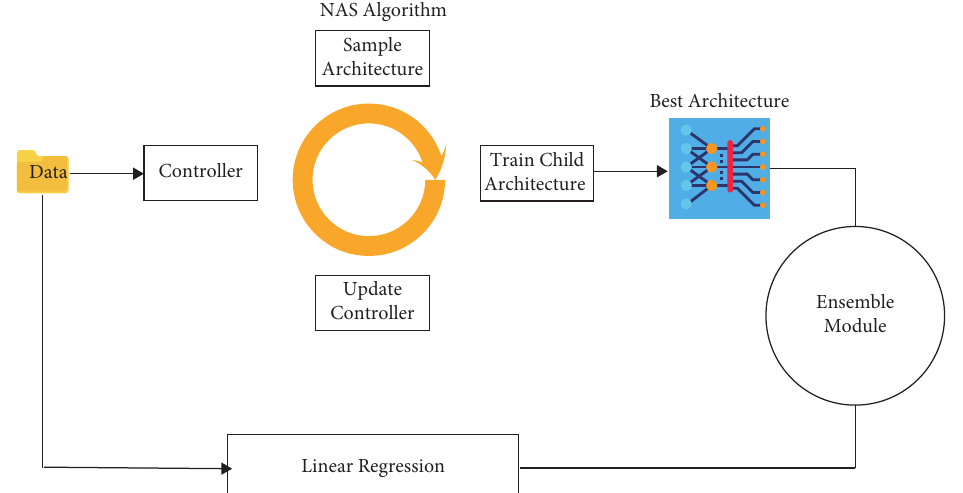
Figure 4: The proposed process for the ensemble learning method.